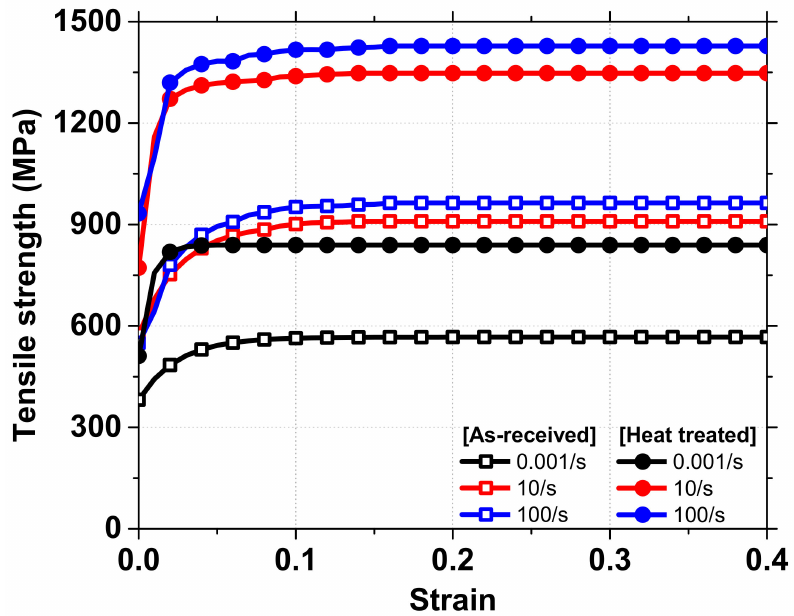
Figure 14. Tensile strength at different strain rate of As-received Material and Material after Heat